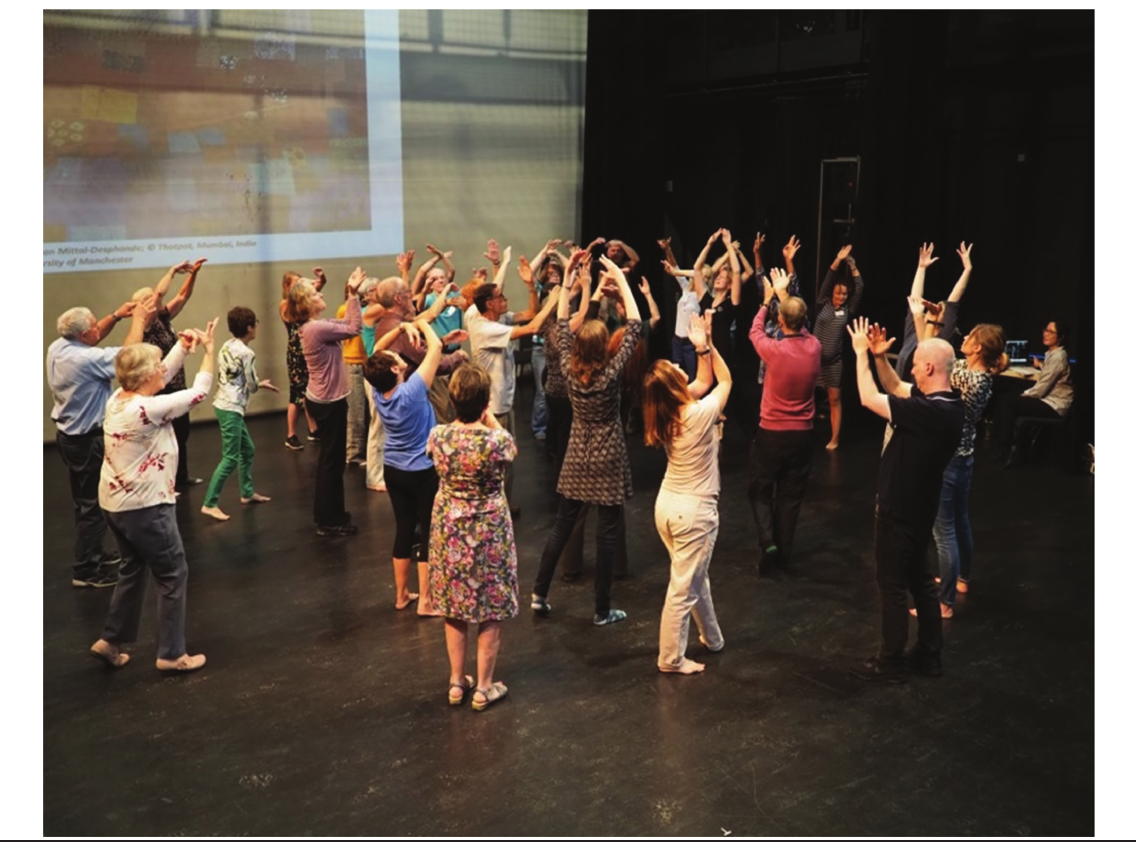
Figure 4. Matthew and Ellen both participated in a dance taster session as part of a research-into- practice workshop, which also involved discussion of research findings and ideas (Photograph by Chris